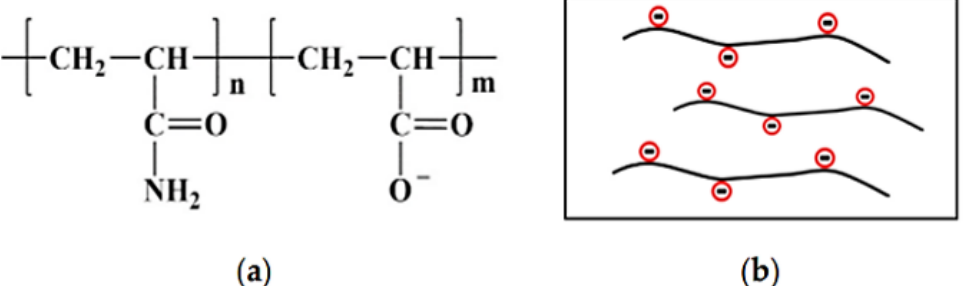
Figure 8. An illustration of the ( a ) chemical structure of HPAM polymer (Reprinted with permission from Liu et al., 2020 [112]) and ( b ) physical structure of HPAM polymer (Reprinted from Shakeel et al., 2020